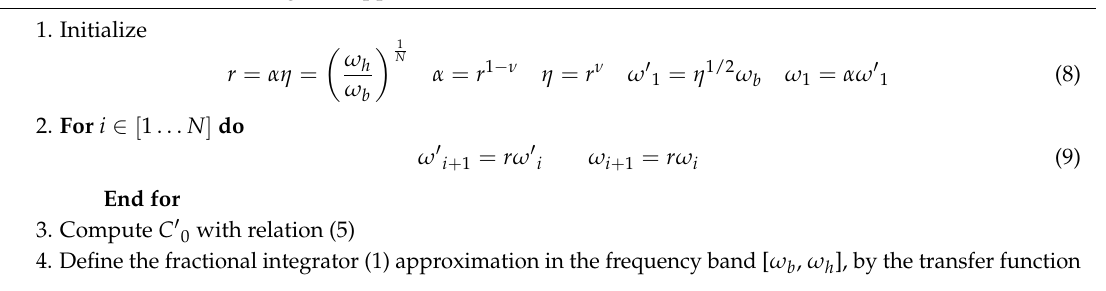
Algorithm 2. Fractional integrator approximation—second